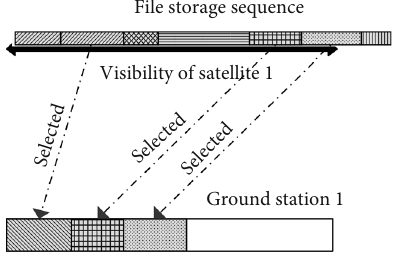
Figure 2: An example of selection